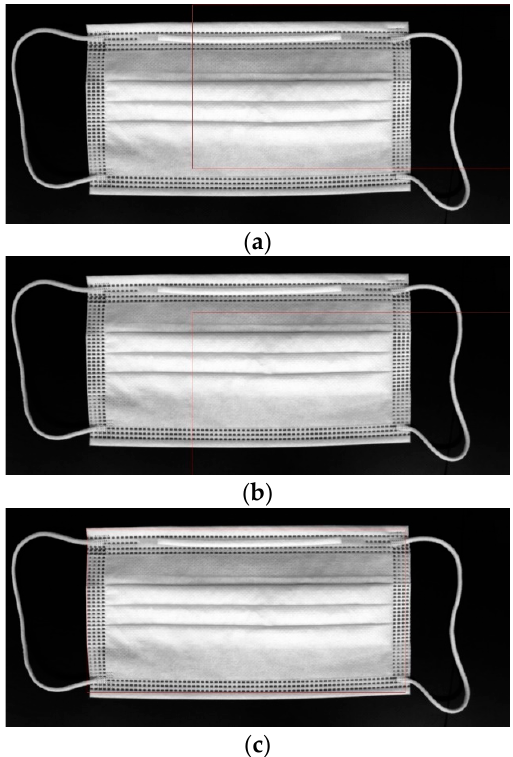
Figure 8. Apply various template matching methods in the mask image, ( a ) apply the minimum cross coefficient method; ( b ) apply the minimum cross correlation method; and ( c ) apply the minimum square difference